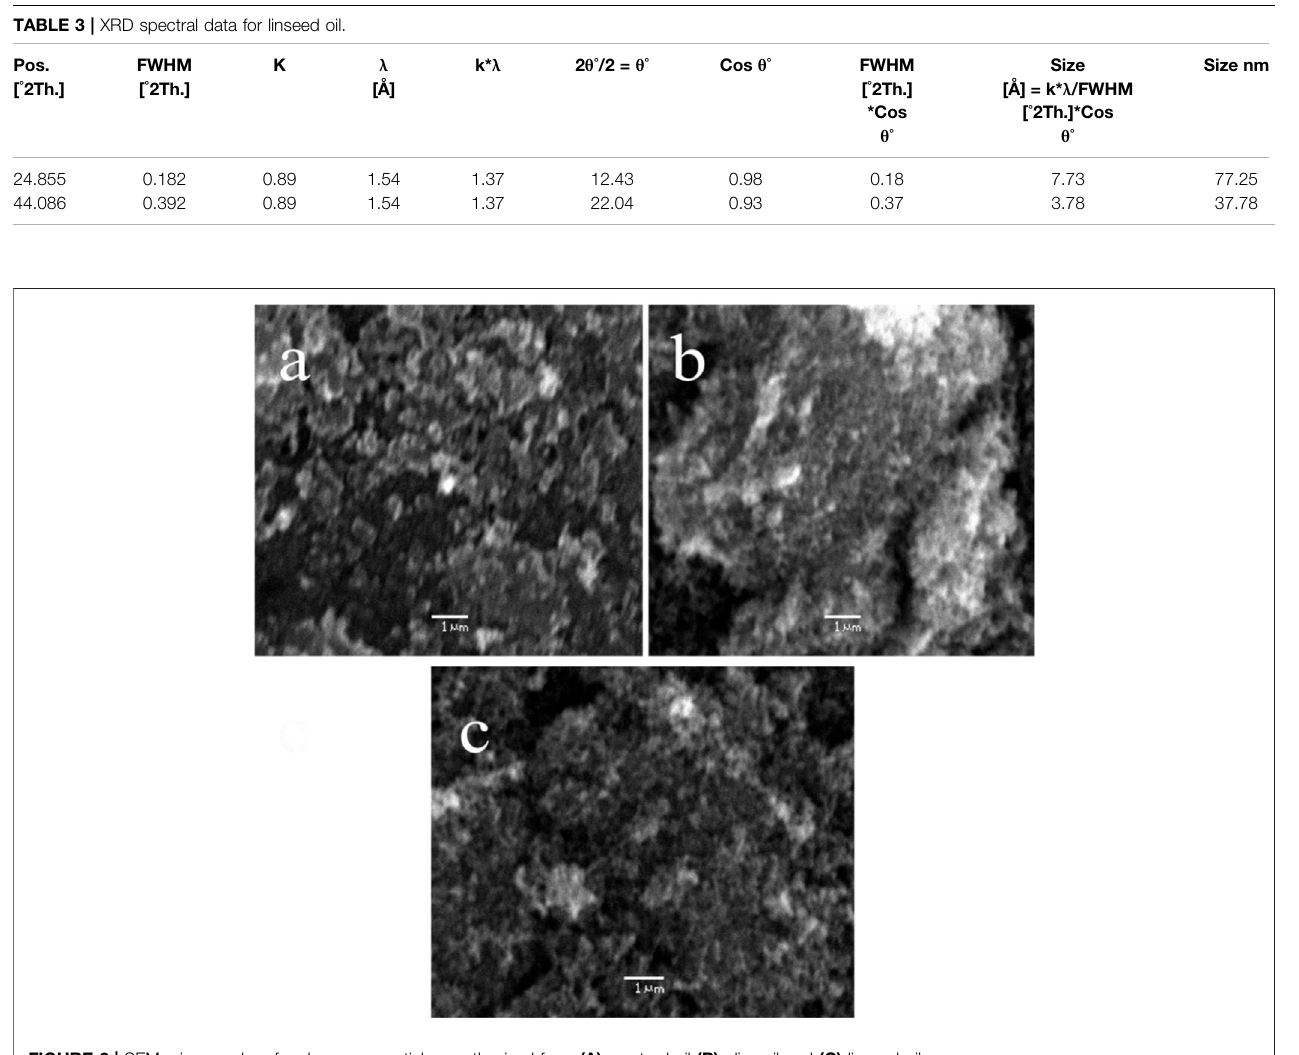
Frontiers in Materials |